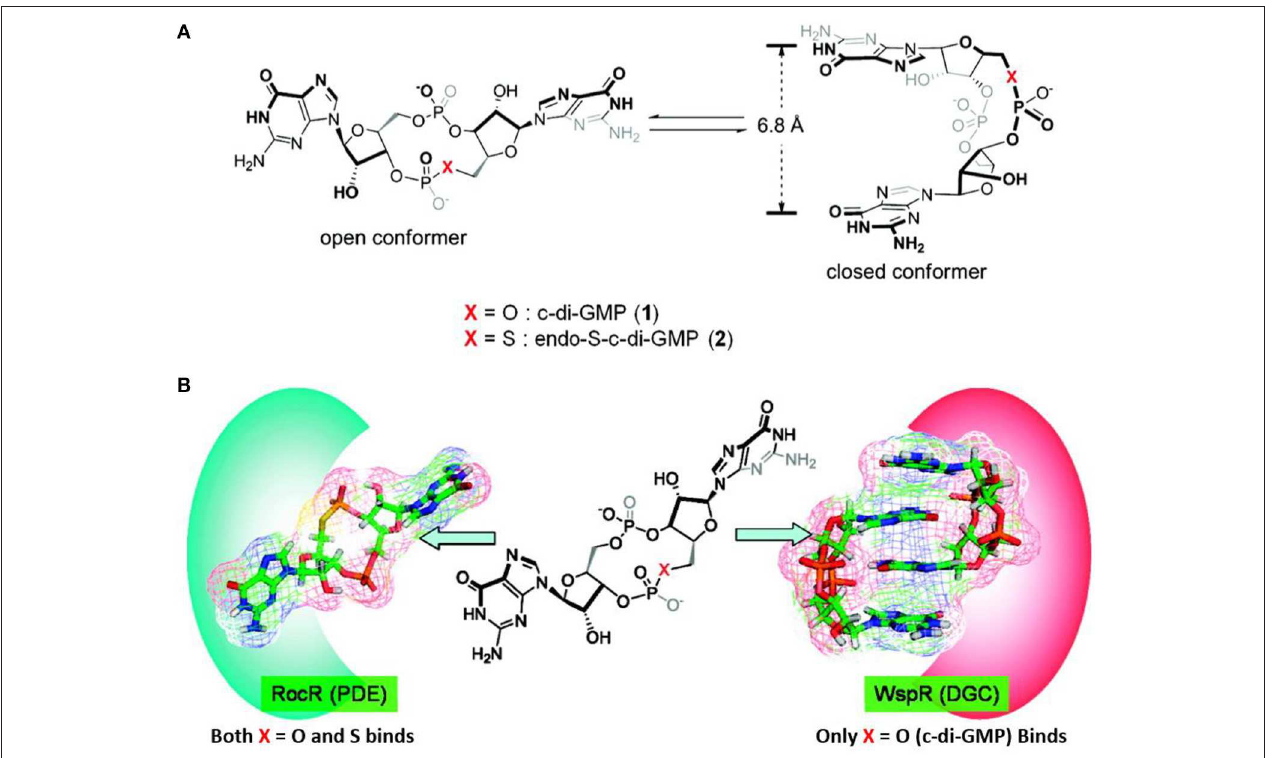
FIGURE 7 | Illustration of the open and closed conformation of X-modified c-di-GMP by Wang et al. (2011). (A) Without enzymes (B) with enzymes